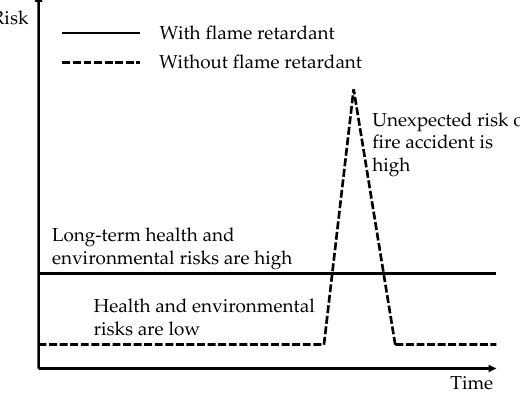
Figure 1. Long- and short-term risks.